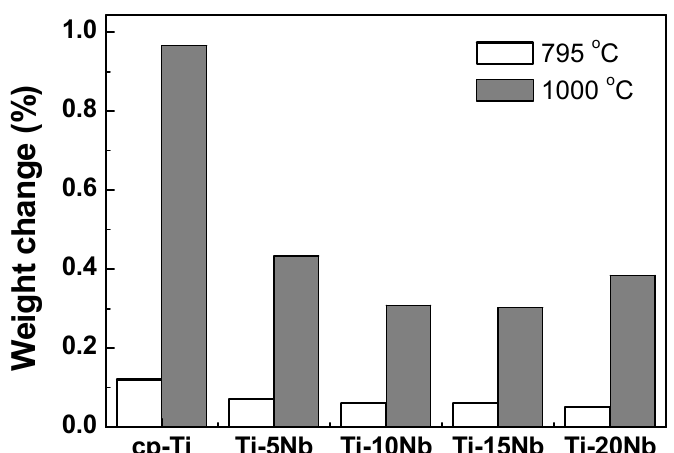
Figure 5. TGA analysis of cp-Ti and Ti-xNb alloys showing various degrees of weight gain (%) by heating in air.